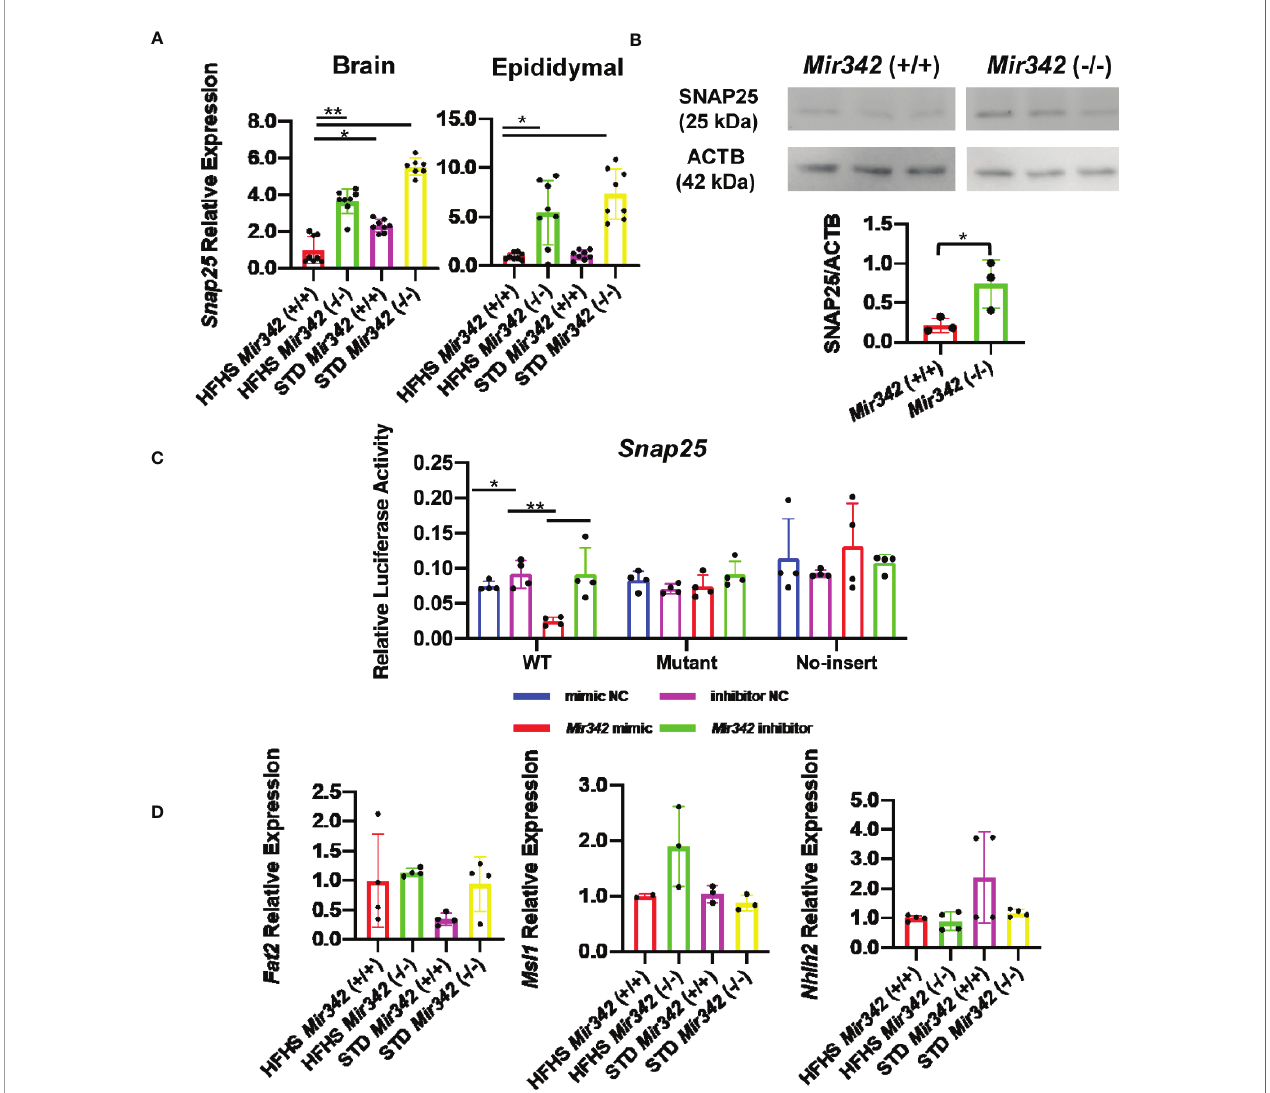
FIGURE 6 | The expression and reporter assay of Snap25 (synaptosomal-associated protein, 25kDa). (A) Relative mRNA expression of Snap25 normalized by Rplp0 and Rn18s in brain and epididymal fat tissues detected by RT-qPCR. (B) Western blot analyses and quanti fi cation of SNAP25 protein levels in hypothalamus. (C) Dual-luciferase reporter assay. pmirGLO-Snap25 WT 3 ’ -UTR, pmirGLO-Snap25 MT 3 ’ -UTR, and pmirGLO no-insert control plasmids were cotransfected with Mir342 mimic, Mir342 inhibitor, negative control siRNA (mimic NC), inhibitor negative control (inhibitor NC) into HEK293T cells, respectively. (D) The expression of predicted target genes (Fat2, Msi1 and Nhlh2) in brain. Data are analyzed by independent t-test or one-way ANOVA with a Tukey test. All data are presented as mean ± SD (*p < 0.05; **p <